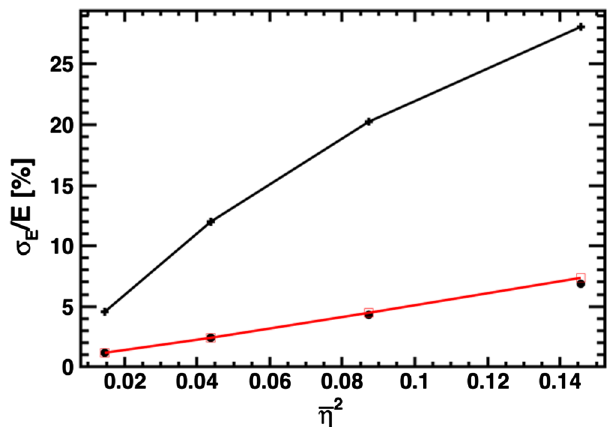
FIG. 5. Relative bandwidth of the photon beam estimated with CAIN (black dots), with the model proposed in this article (open squares) and the model of Ref. [11] (black crosses) as function of ¯ η 2 . Lines are drawn as a further guide to the eye for the analytical models. The laser pulse energy is varied from 1 to 10 J to realize this study. An aperture of 300 μ rad has been used to compute the relative